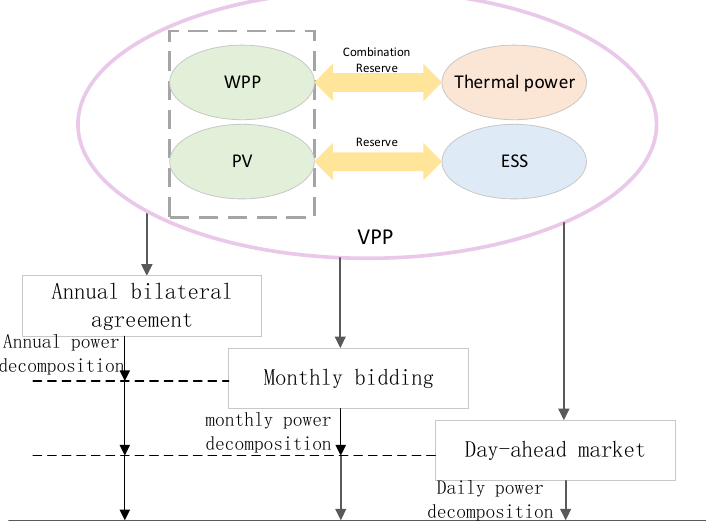
Figure 2. Decomposition form of medium ‐ long term electricity of VPP.